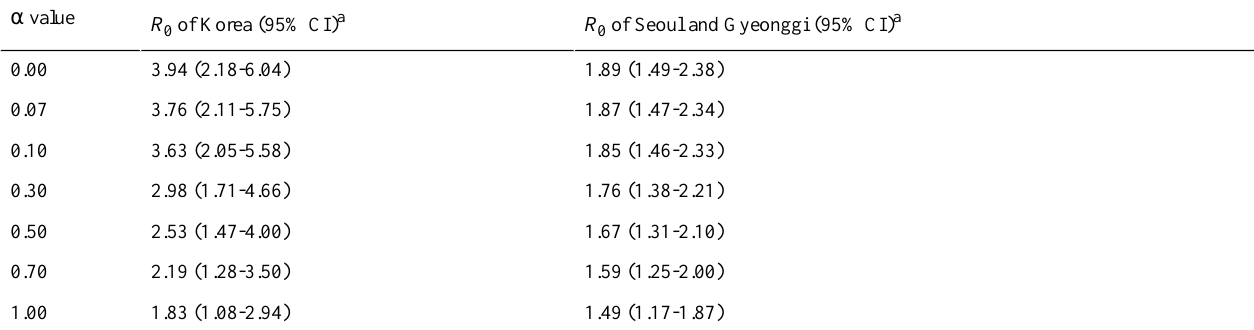
Table 2. Estimation of R 0 by α .